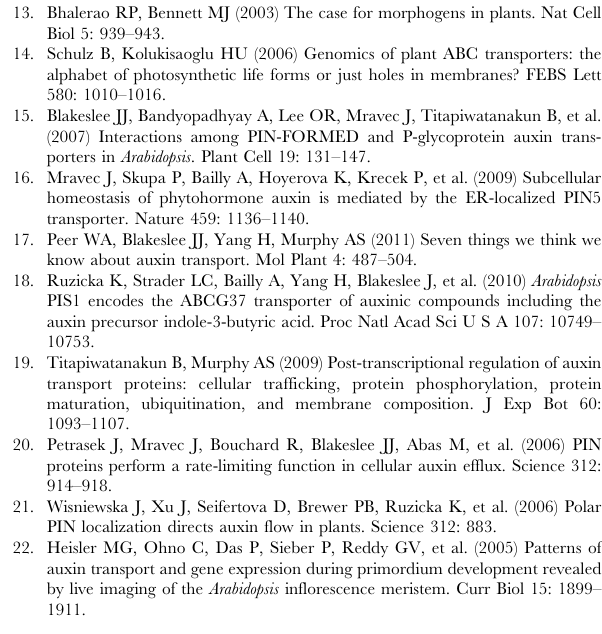
Figure S1 Pairwise alignment of AtAucsia -1 and AtAuc- sia -2 coding sequences. Figure S2 1-NPA sensitivity of ataucsia -1 mutant (SALK_ 117986). (A) 5 days old seedlings were treated with 0.5 and 0.1 m M 1-NPA for 5 days. Density of emerged lateral roots days. The values reported in the panels are means 6 standard were analyzed by Student’s t -test. **P , 0.01; ***P , 0.001 versus wild-type seedlings. Figure S3 AtAucsia-1OX # 2 root and floral phenotypes. (A) Quantification of IAA treatment (0.03 and 0.1 m M) effect on primary root growth of 10 days old wild-type and AtAucsia-1OX # 2 seedlings (B). Flower at stage 13 (anthesis) of wild-type and AtAucsia-1OX # 2 overexpressing line. In wild type flower, anthers are positioned above the stigma and pollen grains are released (upper panel). In AtAucsia-1OX # 2 flowers (lower panel), some developmental defects were visible in the stamens. Arrows highlight stamens with an abnormal orientation, stamen filament fusion and stamen filament of reduced length. Figure S4 AtAucsia -1 and AtAucsia -2 promoter se- quences and Pro AtAucsia-2 ::GUS analysis. (A) Promoter